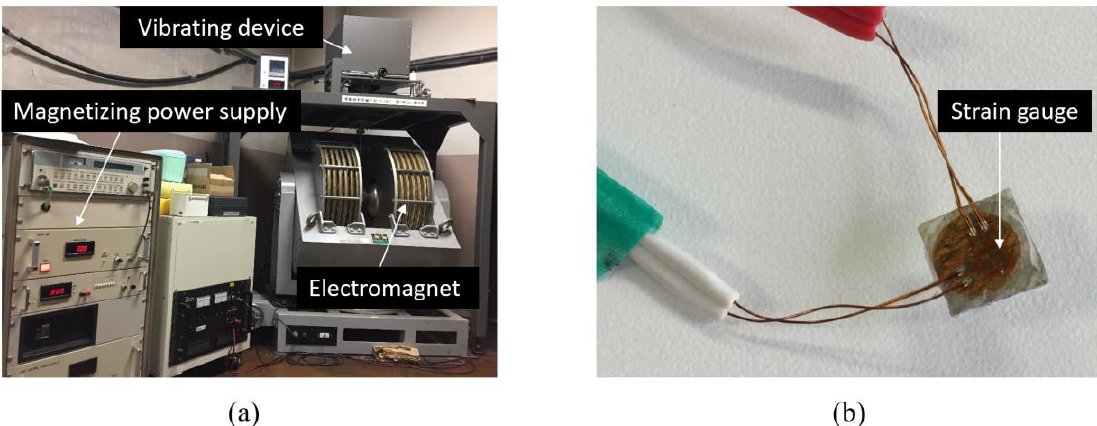
Figure 2. Experimental set up: ( a ) a vibrating sample magnetometer (VSM) machine and ( b ) a magnetostriction measurement specimen.